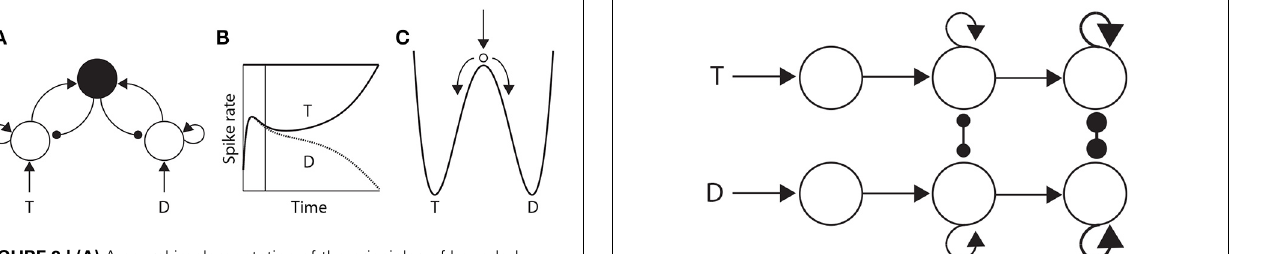
FIGURE 3 | (A) A neural implementation of the principles of bounded integration. Neural populations selective for the decision alternatives (T and D) compete via a common inhibitory pool (solid black circle). Arcs with arrows and filled circles depict excitatory and inhibitory synaptic connectivity respectively. Target (T) and distractor (D) stimuli provide stronger and weaker evidence to the integrator populations respectively. (B) Competitive interactions between integrator populations lead to an increased spike rate by one population (solid) and a decreased rate by the other (dotted). (C) Cartoon depiction of an attractor “energy landscape” supported by the neural model, where the energy decreases over time. An unstable steady state (high energy) separates two attractors (low energy), corresponding to the target and the distractor. The ball depicts the state of the network, which is drawn toward the unstable steady state at stimulus onset (vertical arrow), and from which it is repelled toward one of the “attractor basins” (bent arrows). Descent into the attractor basin corresponds to the firing-rate excursion of the target population in (B) , where the vertical line approximates the position of the ball in (C) . The evolution of the network state (conceptually, the movement of the ball) is faster (slower) under speed (accuracy) conditions.